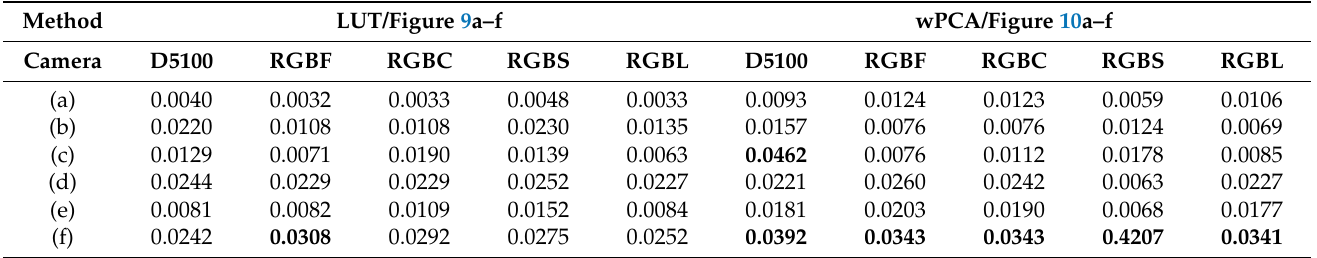
Table 3. The values of E Ref for the cases shown in Figures 9a–f and 10a–f. The values larger than 0.03 are shown in bold.